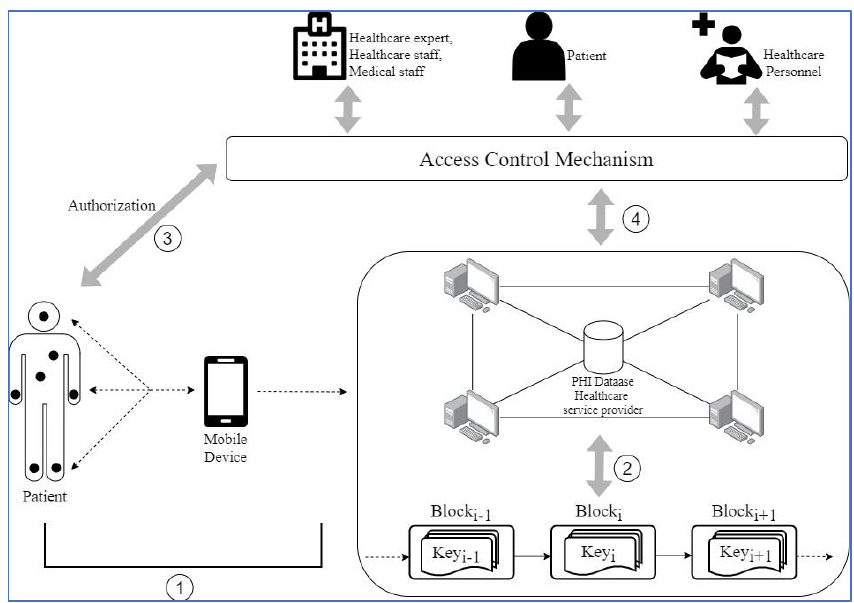
Figure 1. The proposed authorization and access control of the medical care information system.